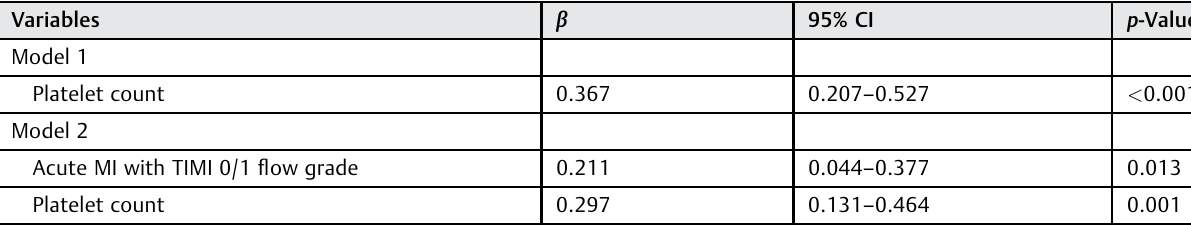
Table 2 Multivariate liner regression analysis of determinants of AUC 30 levels